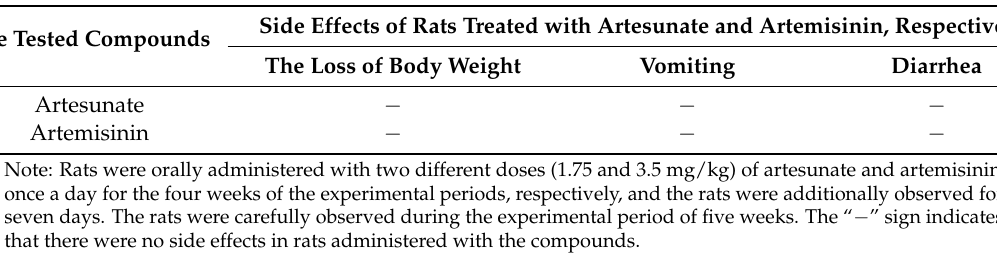
Table 3. The results of in vivo toxicity test of artesunate and artemisinin.